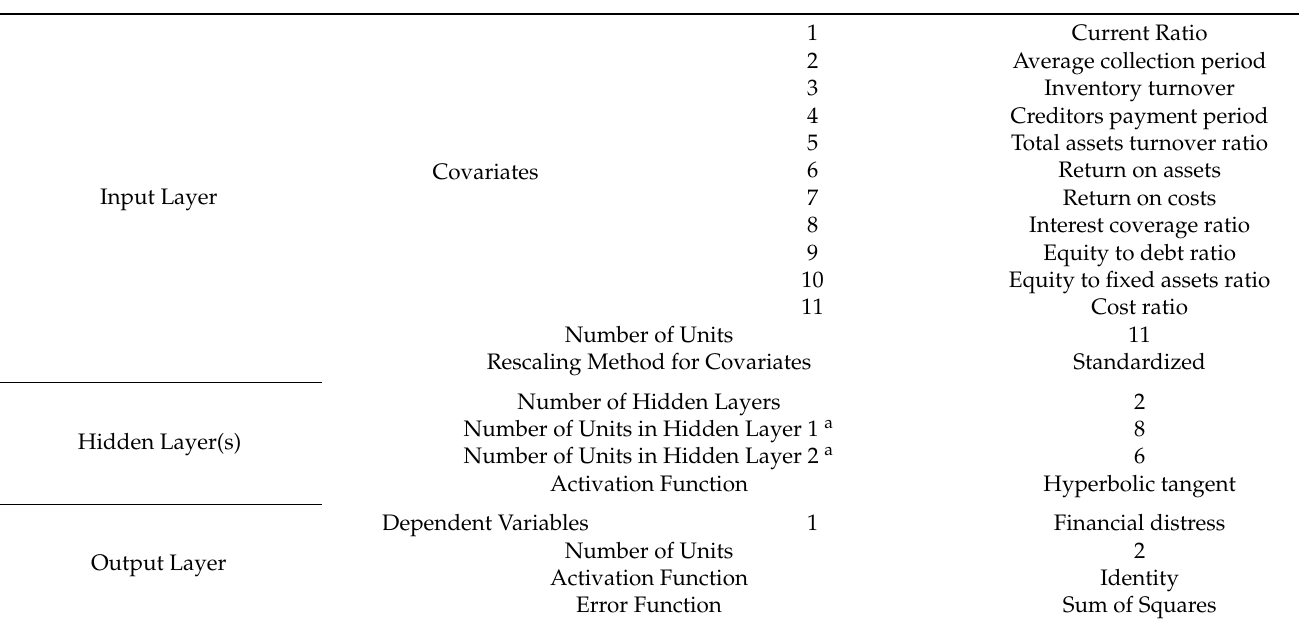
Table 9. Network